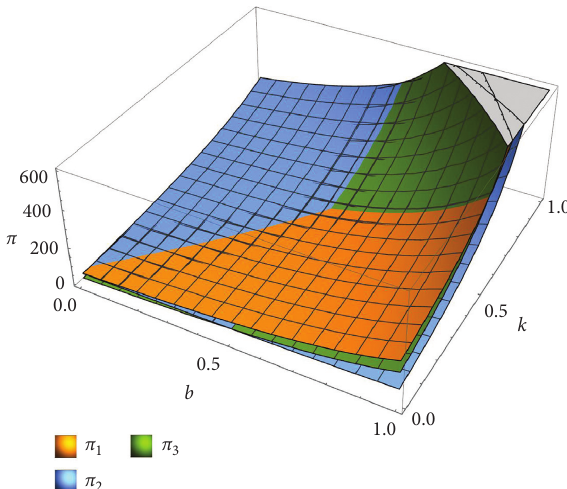
Figure 6: The influence of k and d on corporate profits when b � 0.5.